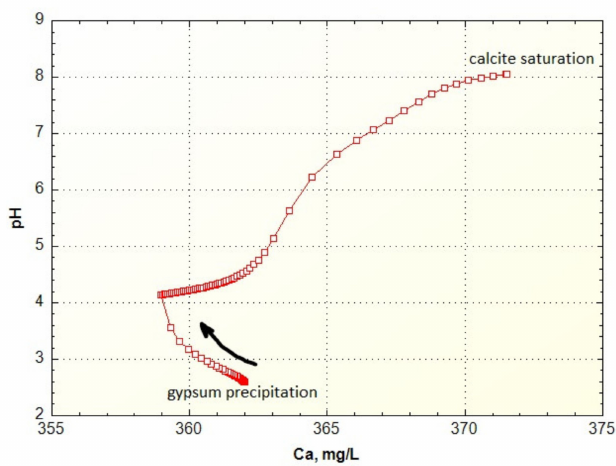
Figure 7. Change in Ca concentration during titration of Berkeley Pit water with